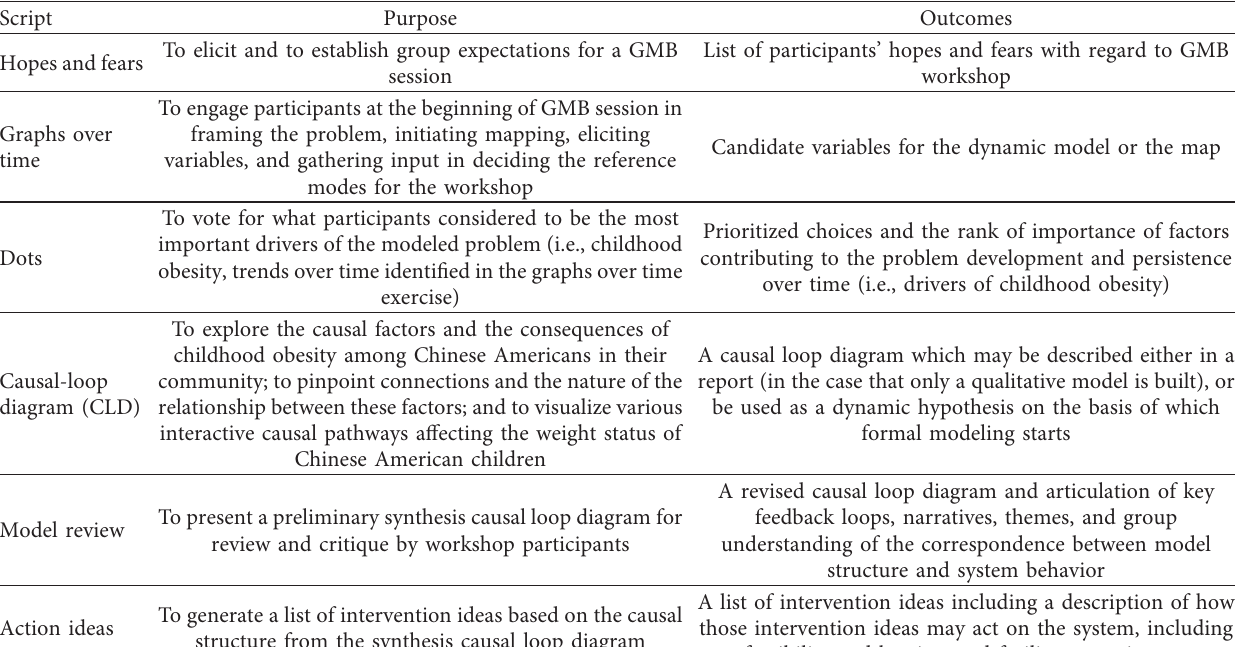
Table 1: The script choice, purpose, and